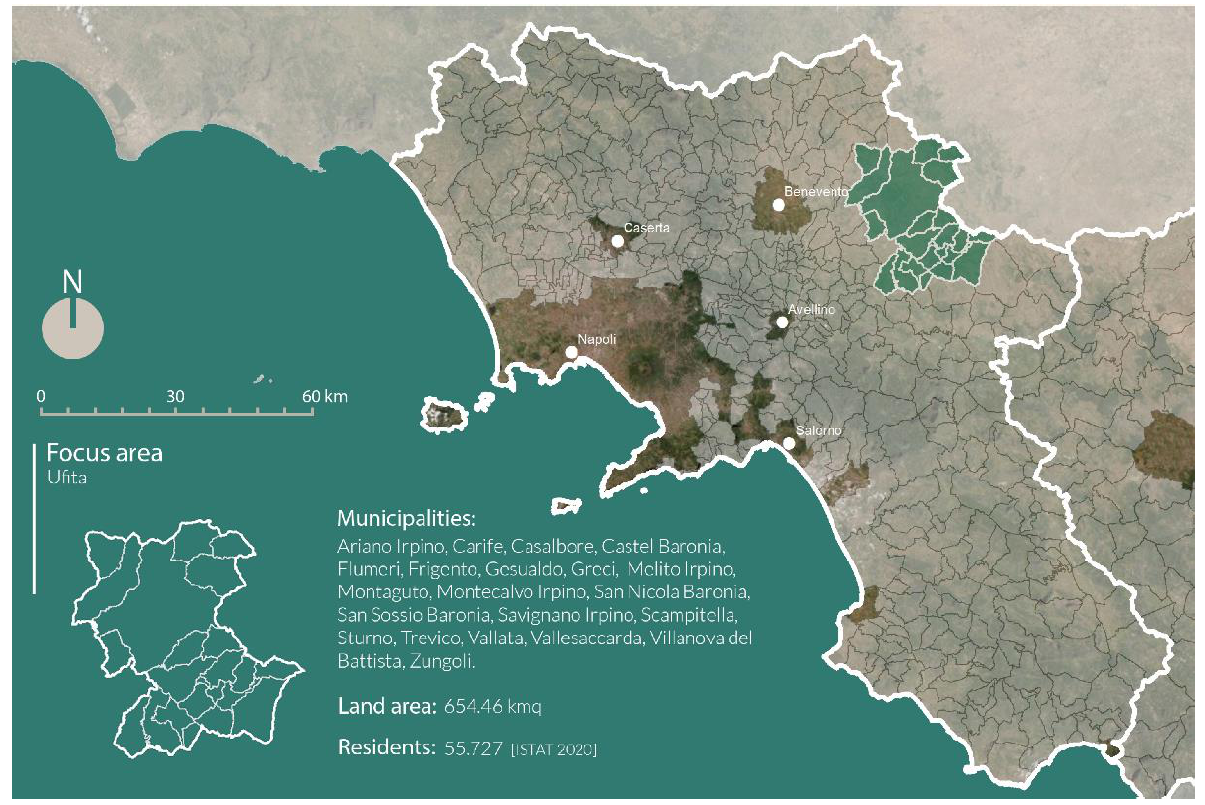
Figure 2. The Ufita focus area in the Campania region © RI.P.R.O.VA.RE Project.